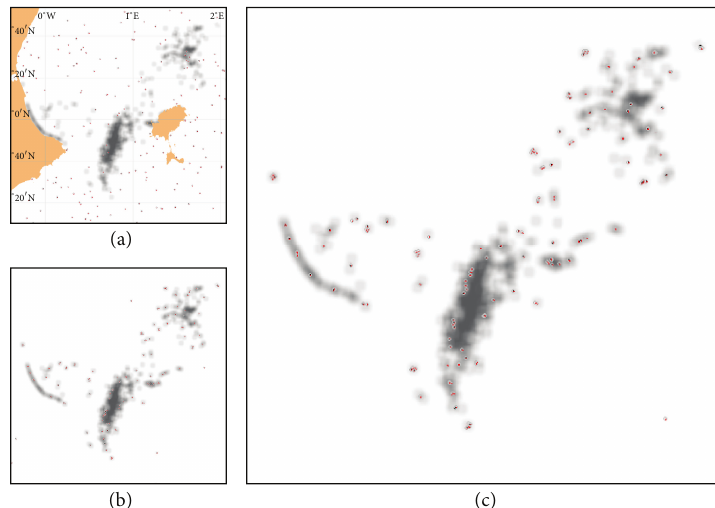
Figure 5: Distribution of agents for the task of detecting the perimeter of an oil spill on a map with several slicks: (a) geographical location of the spill and initial position of agents, (b) distribution of agents at time 𝑡 = 15000 s, and (c) distribution of agents at time 𝑡 = 30000 s.